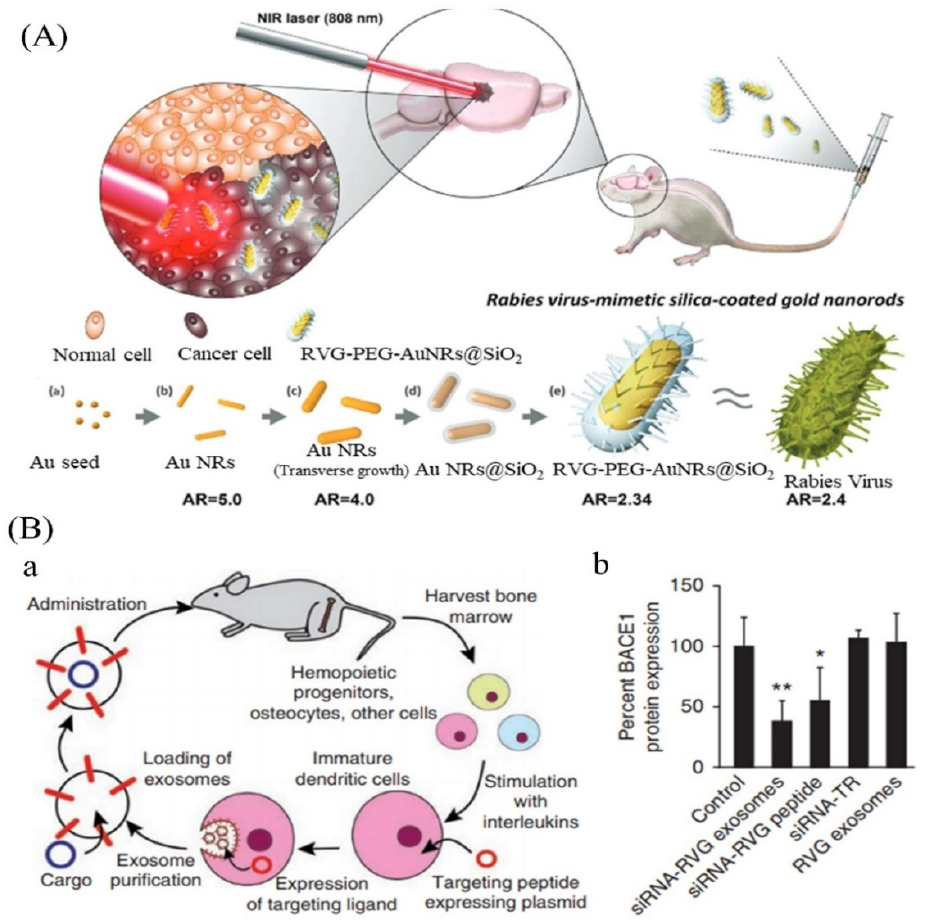
Figure 5. ( A ) Rabies virus mimicking silica-coated gold nanorods bypass the BBB via neuronal pathways to treat brain disease. ( B ) Delivery of therapeutic siRNA to the mouse brain by systemic injection of exosomes. ( a ) Schematic illustration of the preparation of exosomes; ( b ) gene silencing efficiency by different vehicles. Adopted from Wang et al., 2020 [123].